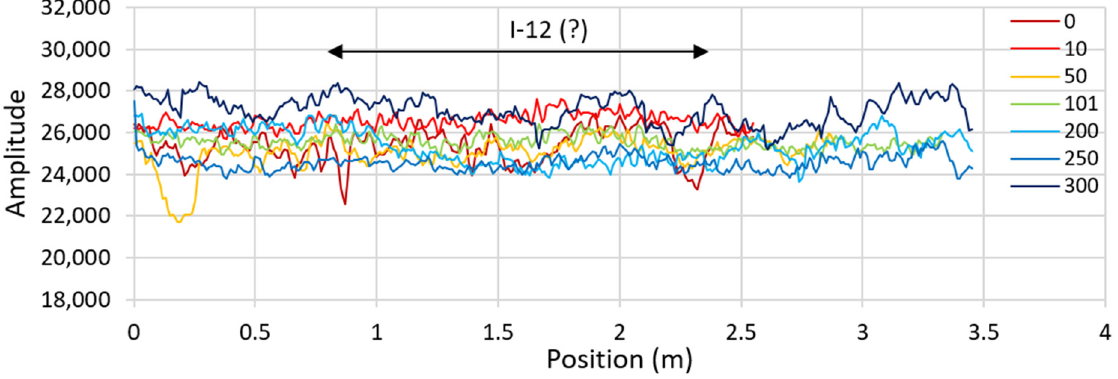
Figure A12. 2.6 GHz DW amplitudes on geotextile (I-12) in the longitudinal direction vs. K loadings.